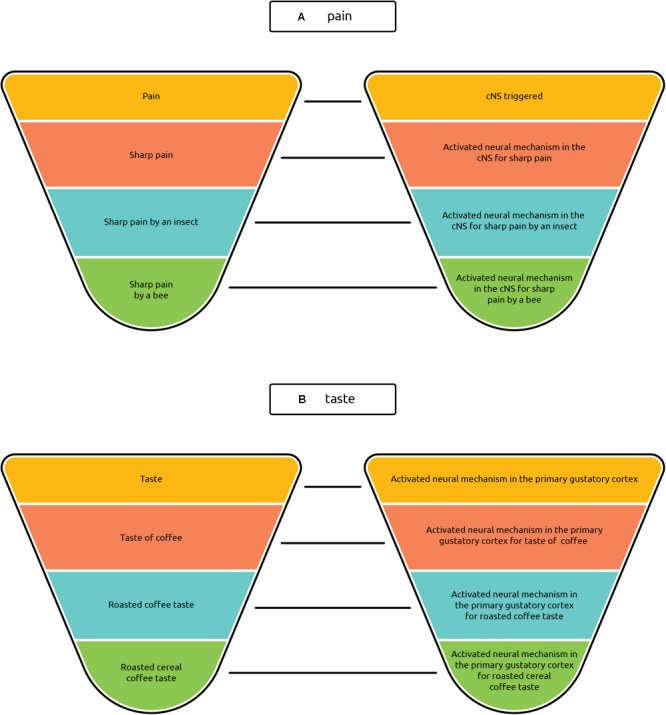
Simplified hierarchies of types. The diagrams show a one-to-one correspondence between simplified hierarchies of types. (A) displays the simplified hierarchy for phenomenal types of pain, (B) for phenomenal types of taste. On the right halves of both pictures, the corresponding neural types are assorted. Both the phenomenal and neural types are ordered according to the degree of generality: on the top the more general types are located, at the bottom the least general. An activated central nociceptive system (cNS in the diagram) is considered the neural correlate of pain; activation of the primary gustatory cortex is considered the neural correlate of taste (Chen et al., 2011; Gazzaniga et al., 2014, p. 176; Peng et al., 2015).